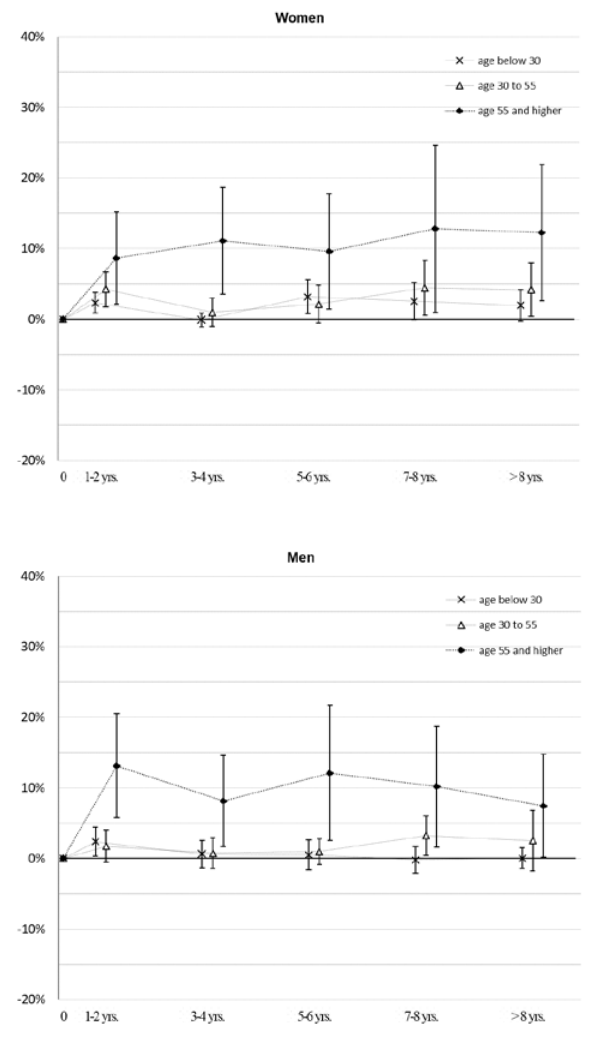
Figure 4 : Age-differences in time-effects of relationship endings on social isolation (concurrent isolation from all social spheres; linear-probability models with fixed effects, percentage points and 95%-confidence limits) A) Separations of live-in